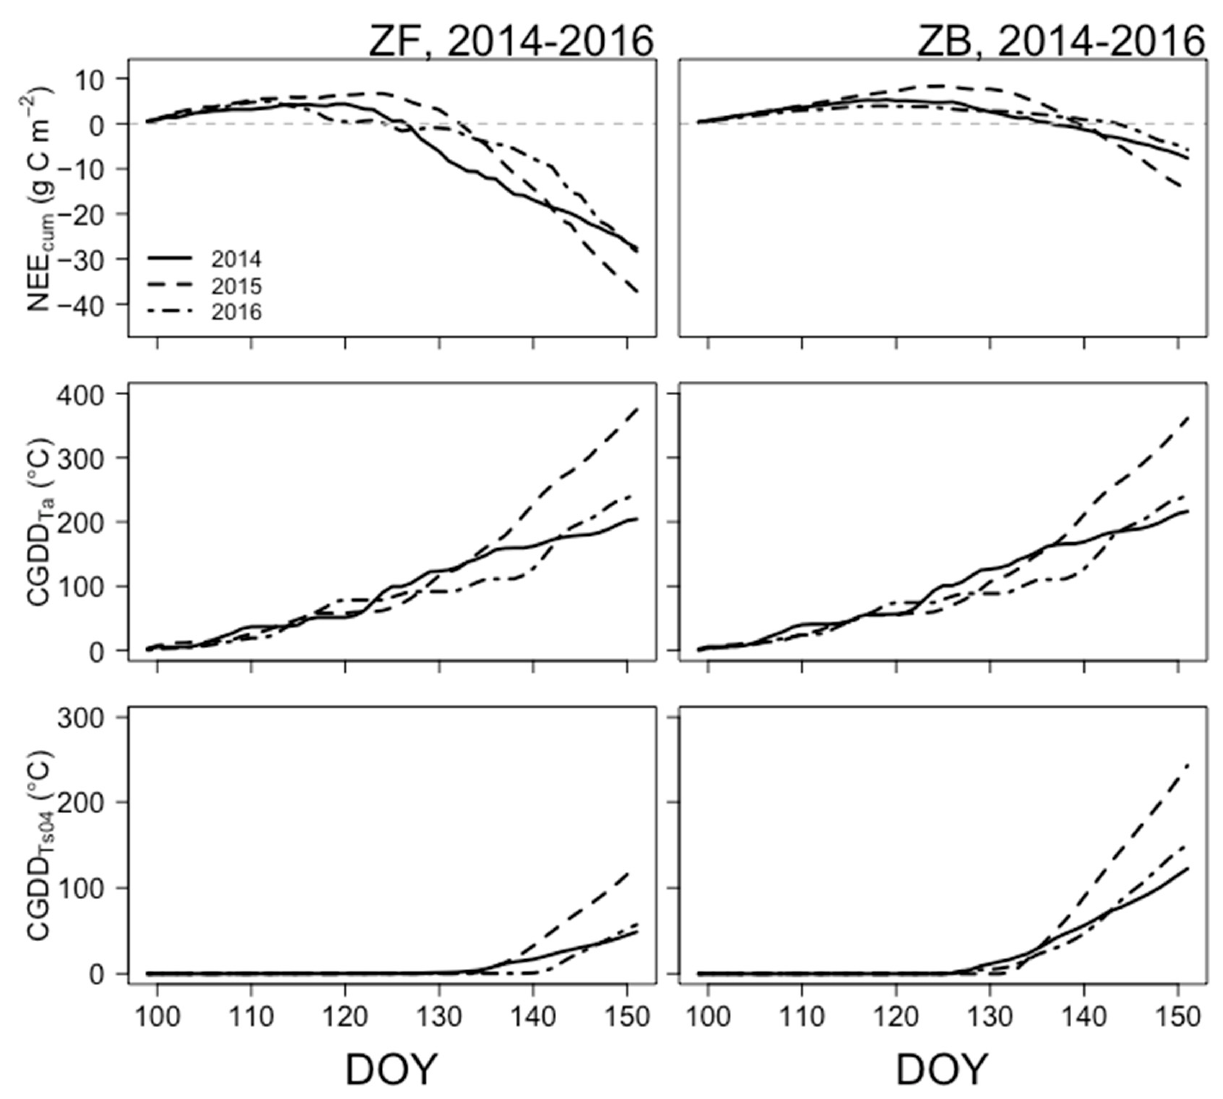
Figure 4. Cumulative net ecosystem exchange of CO 2 (NEE cum ; g C m − 2 , top ), cumulative growing degree days of daily mean air temperature (CGDD Ta ; ◦ C, middle ), and cumulative growing degree days of daily mean surface soil/peat temperature (CGDD Ts04 ; ◦ C, bottom ) for ZF ( left panel) and ZB ( right panel). Solid, dashed, and long-dashed black lines denote data for DOY 99–155 for 2014, 2015, and 2016, respectively. Dashed grey zero-lines in the top panel denote the transition from a cumulative CO 2 source (positive, ecosystem carbon loss) to cumulative CO 2 sink (negative, ecosystem carbon gain).